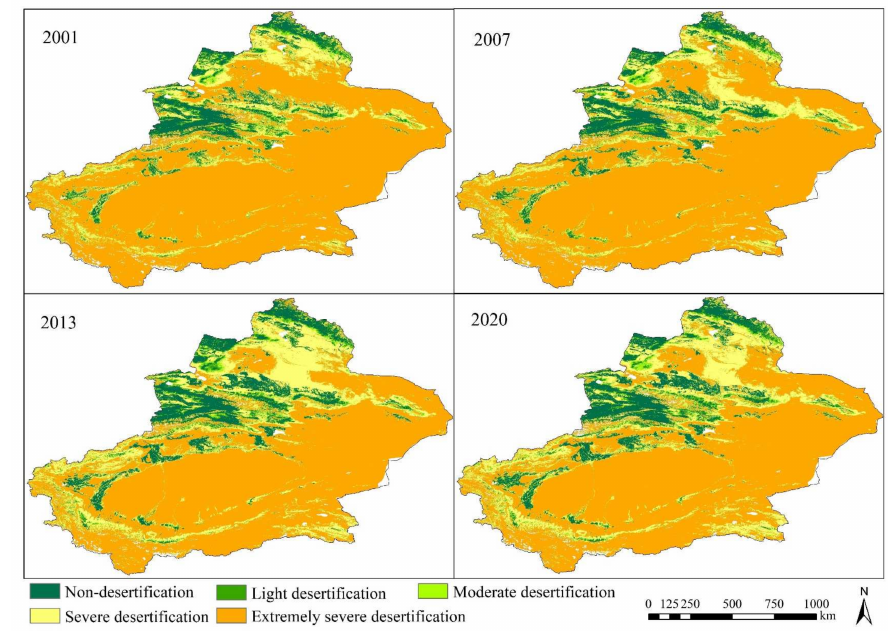
Figure 14. Desertification degree of Xinjiang in different